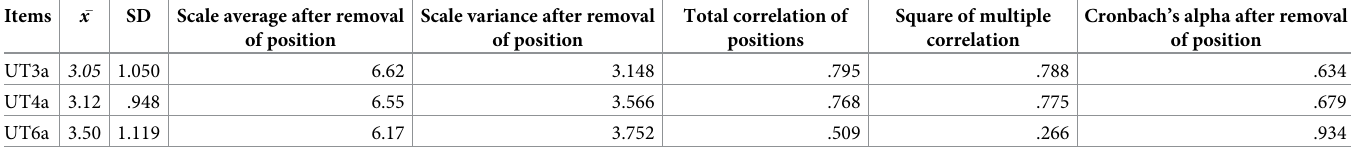
Table 12. Distrust scale items